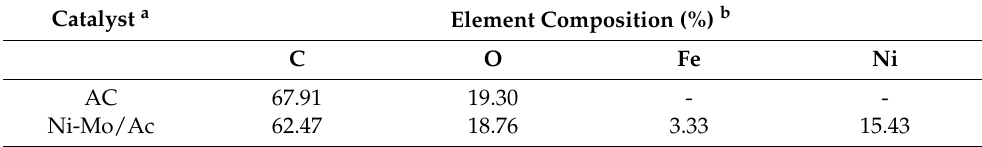
Table 4. Element composition of the catalyst determined by FESEM-EDX.